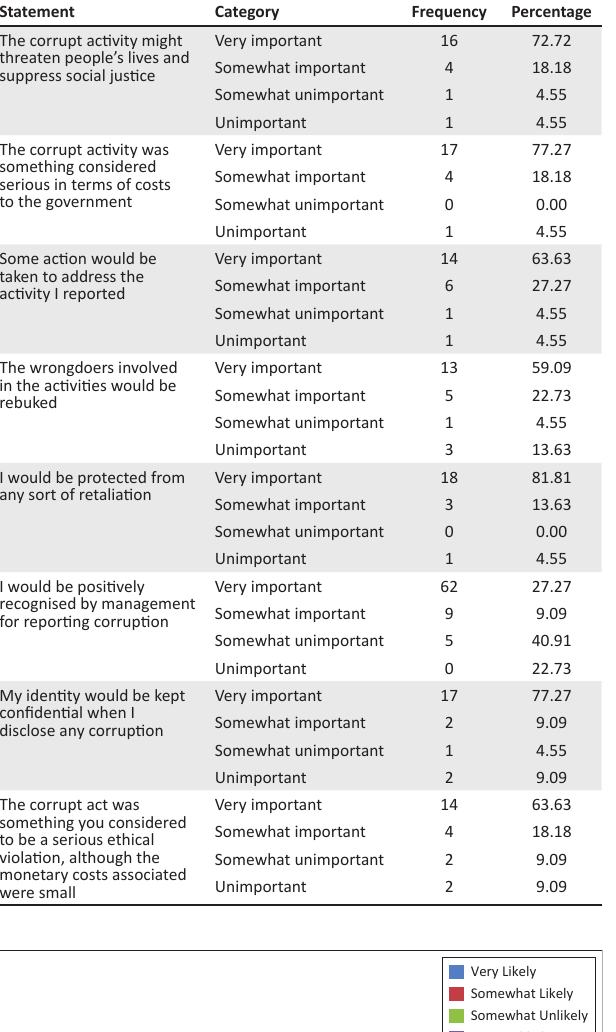
TABLE 2: Factors enabling whistle-blowing